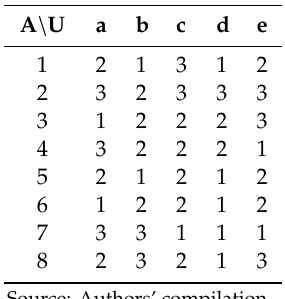
Step 2: attribute reduction. Table 2 is the consistent decision table, and the clear function attribute reduction can be